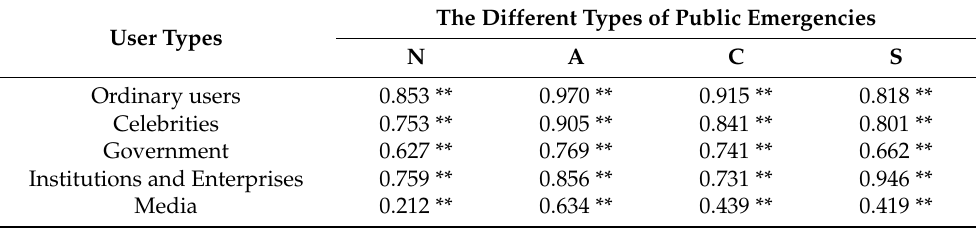
Table 8. The interrelation test of different user types on topic out-degree and emotion